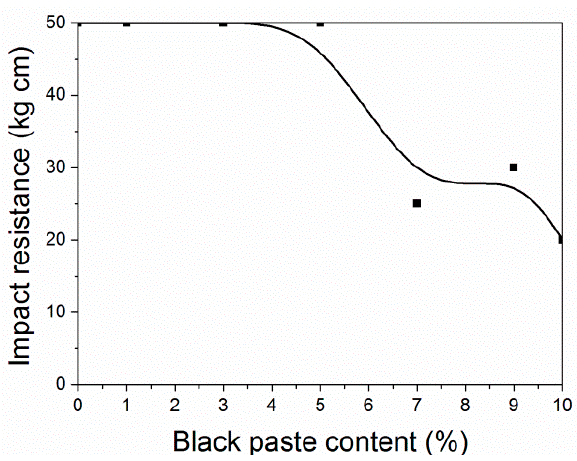
Figure 6. Effect of black paste content on the impact resistance of the coatings.